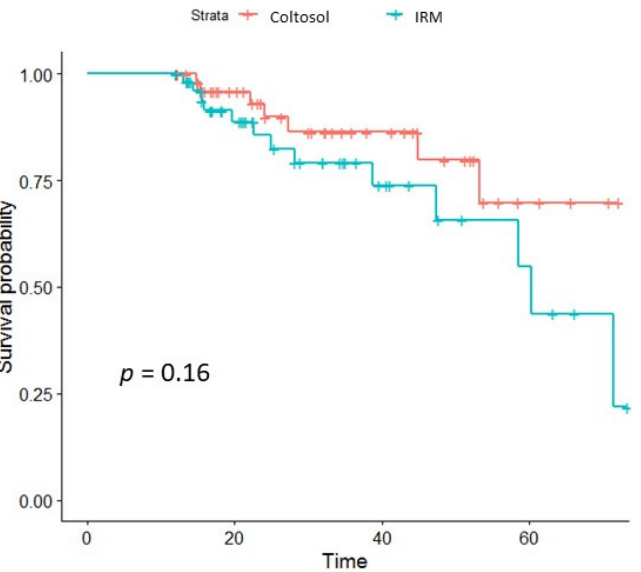
Figure 1. Kaplan-Meier survival curves: survival of Coltosol vs. survival of IRM filled teeth post pulpotomy. Crosshatches indicate censoring